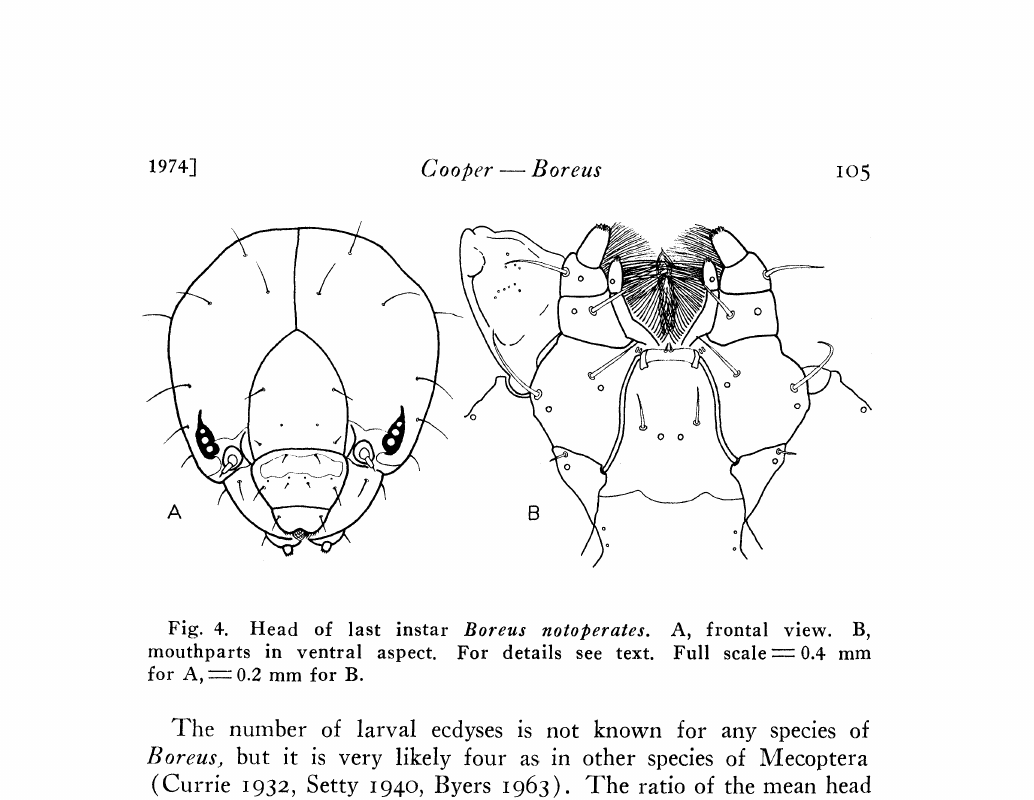
Fig. 4. Head of last instar Boreus notoperates. A, frontal view. B, mouthparts in ventral aspect. For details see text. Full scale--0.4 mm for A, 0.2 mm for